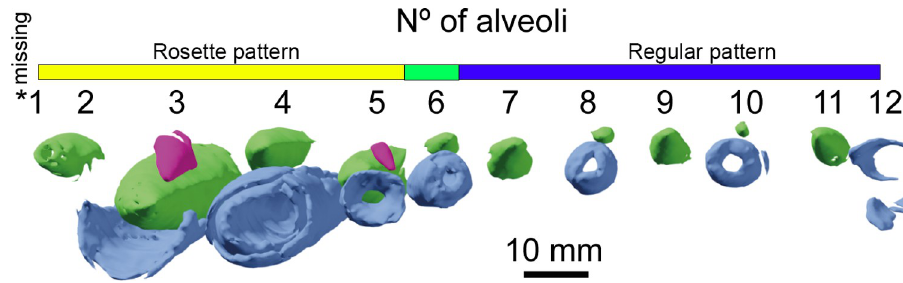
Fig 5. CT-scan of the holotype of Iberospinus natarioi (ML1190-1), showing the erupted teeth and replacement teeth. Scale bar is 10 mm. Voxel size of the model: 0.100628. Blue , erupted or semi-erupted teeth, Green , first replacement teeth, Fuchsia , second replacement